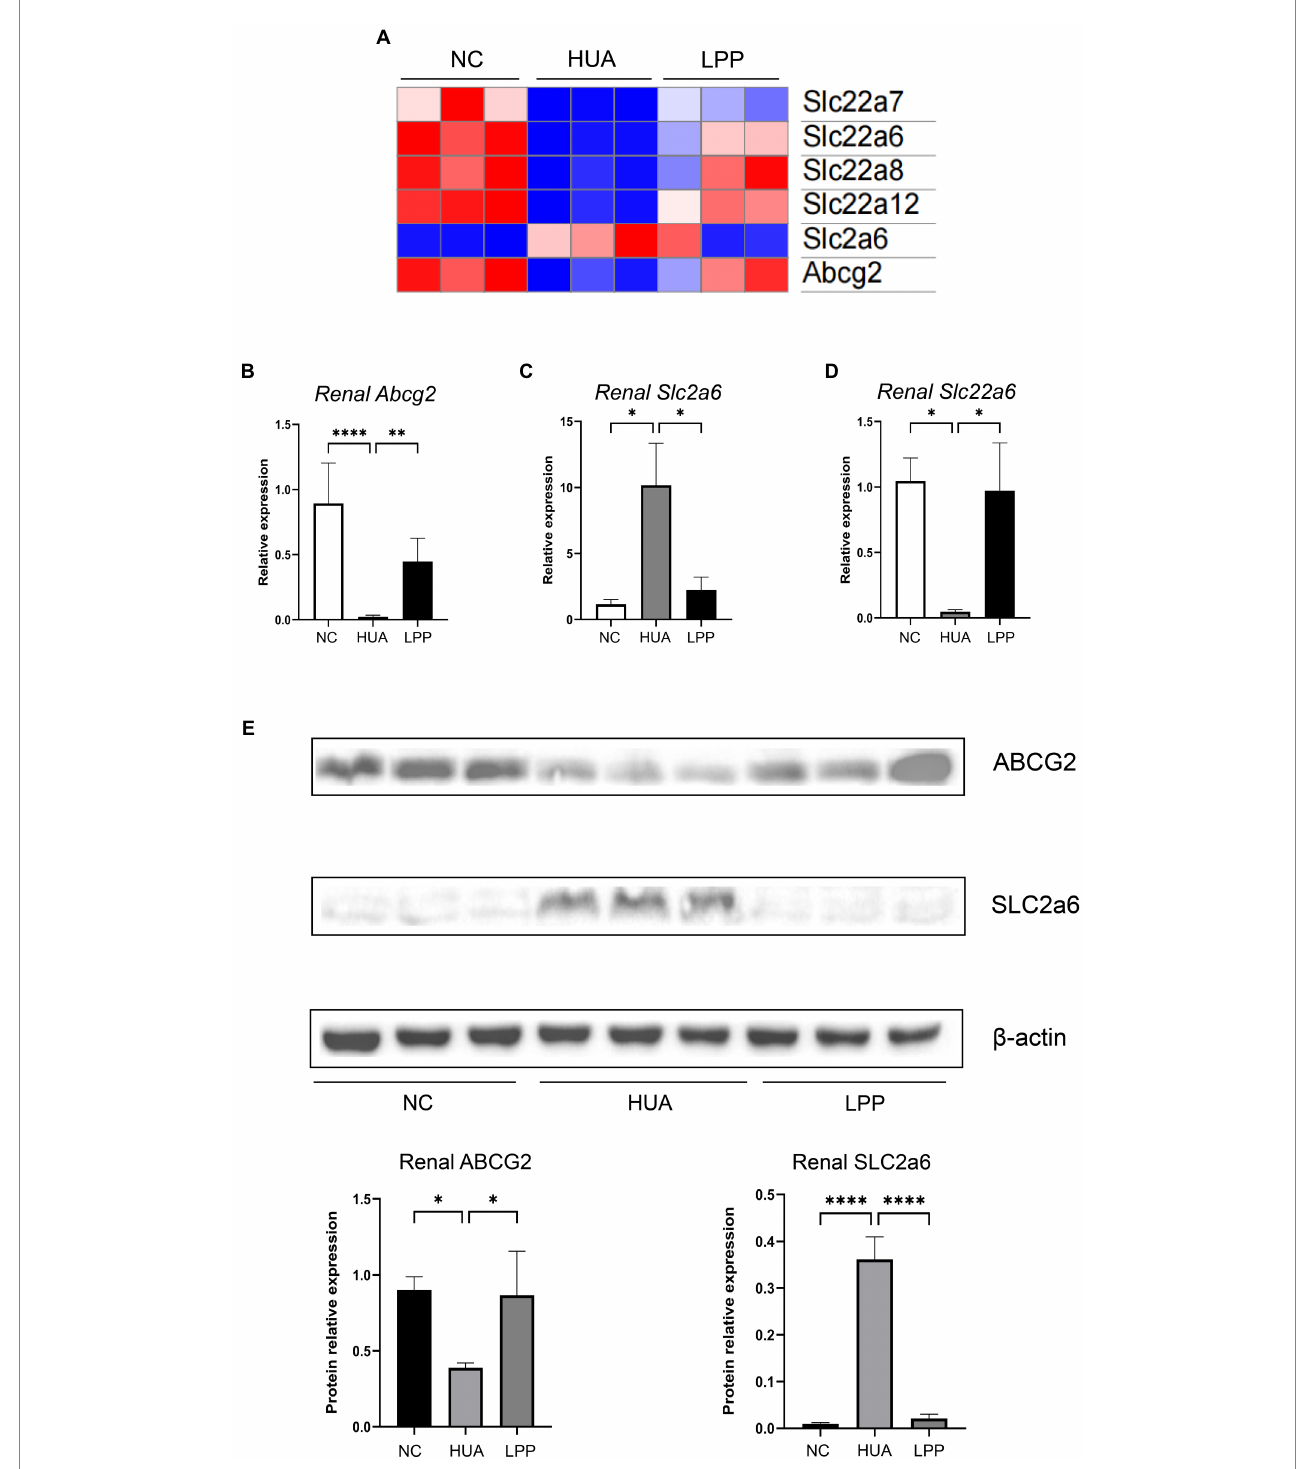
FIGURE 3 LPP altered the expression of uric acid transport-related proteins in renal tissue. (A) Heatmap of expression of UA transporters in renal measured by RNA- seq. ( B–D ) Relative expression of renal Abcg2 (B) , Slc2a6 (C) and Slc22a6 (D) mRNA normalized with β -actin ( n = 6 per group). (E) Representative western blotting image of ABCG2 and SLC2a6 in renal tissue. The protein expressions were quantitated by Image J software and normalized by β -actin ( n = 3 per group). Bars are means ± SD, p < 0.05 was set as the threshold for significance by one-way ANOVA followed by post hoc comparisons using Tukey’s test for multiple groups’ comparisons, * p < 0.05; ** p < 0.01; *** p < 0.001; **** p <